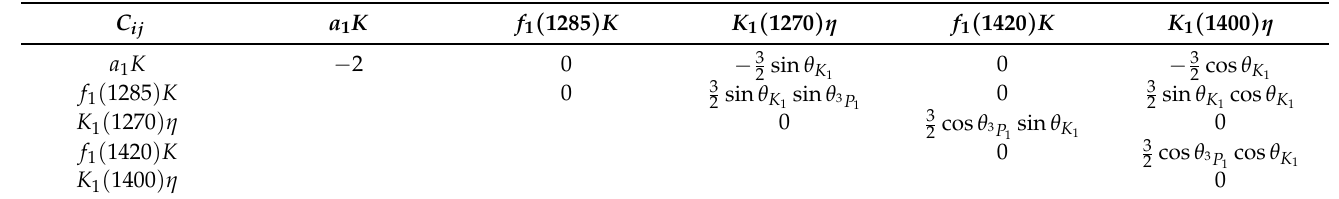
Table 9. C ij coefficients in Equation (16) for axial and pseudoscalar pairs coupled to J P = 1 −